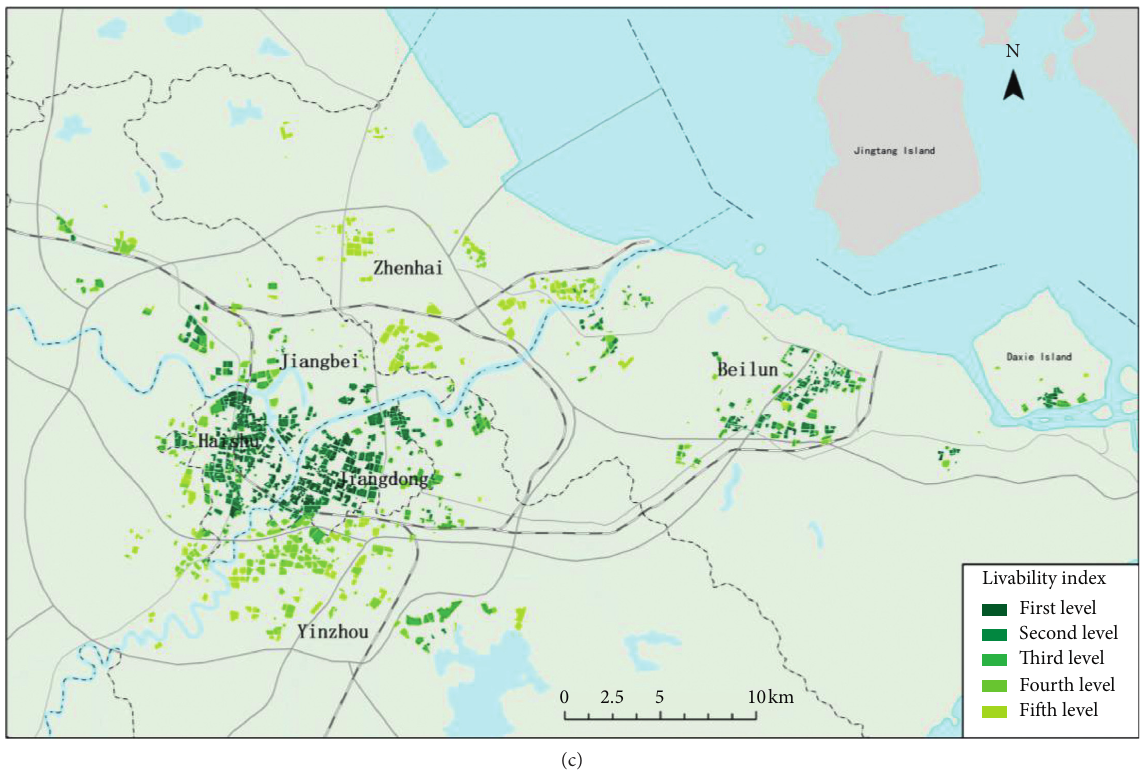
Figure 6: The spatial distribution of communities with different livability levels. (a) The preferences of the youth group. (b) The preferences of the middle-aged group. (c) The preferences of the elderly